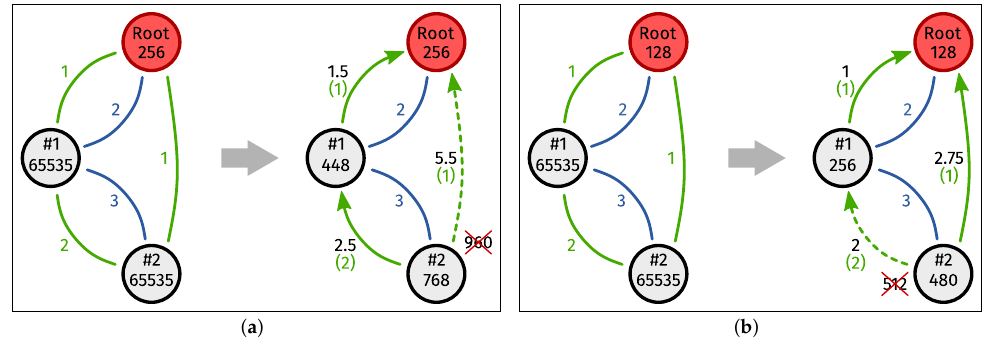
Figure 6. Comparison of upward topology formation between the Parent Oriented Objective Function (POOF) [9,10] and DRiPLOF. All nodes have a sub-GHz interface (green) and a 2.4 GHz interface (blue). Inferred metrics are displayed in the same color as their corresponding interface; normalized metrics are written in black; the arrows indicate which interface is preferred. ( a ) Upward topology formation under POOF. ( b ) Upward topology formation under DRiPLOF. Note that I node = 2, IL max = 1, IL div = 4, and S =